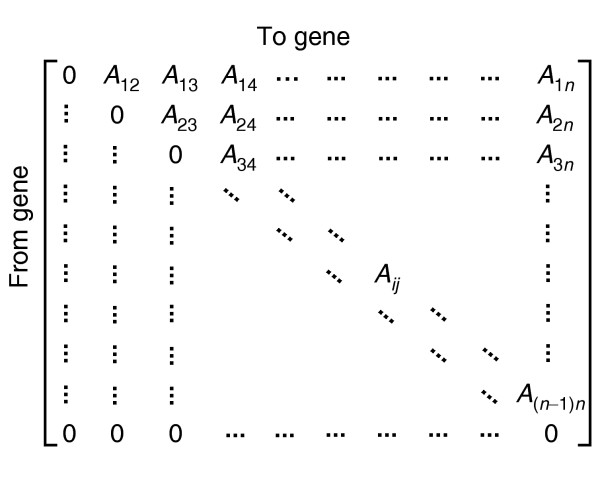
A visual representation of the agreement matrix used as input to robust and consensus clustering. The n × n matrix is upper triangular. Each cell within the matrix, referenced by column i and row j, represents the number of clustering methods that have placed gene i and gene j into the same cluster. In other words, the number represents the agreement between clustering methods concerning gene i and gene j.